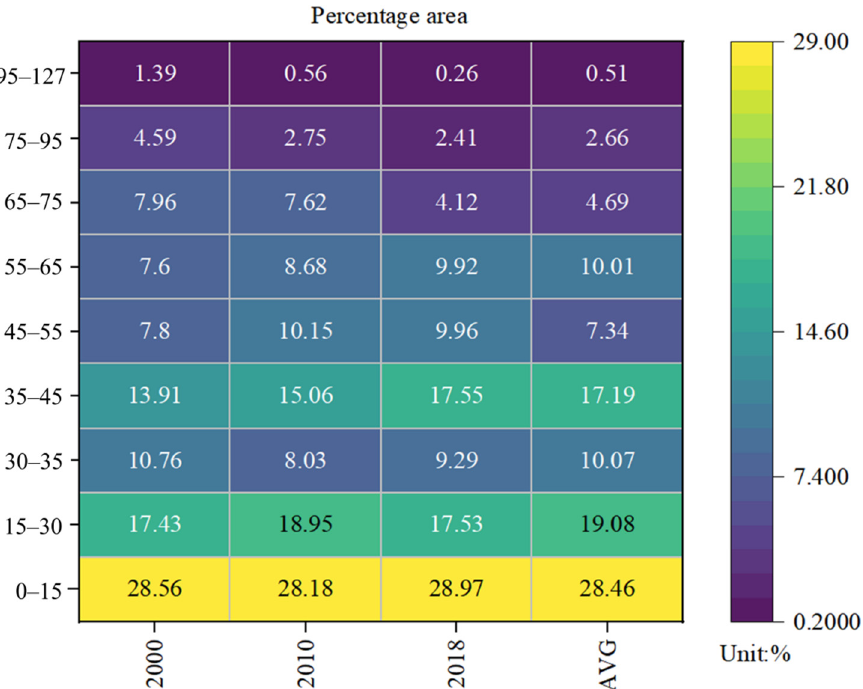
Figure 2. The percentage of the classified area of the annual average concentrations of PM 2.5 in Africa from 2000 to 2018.